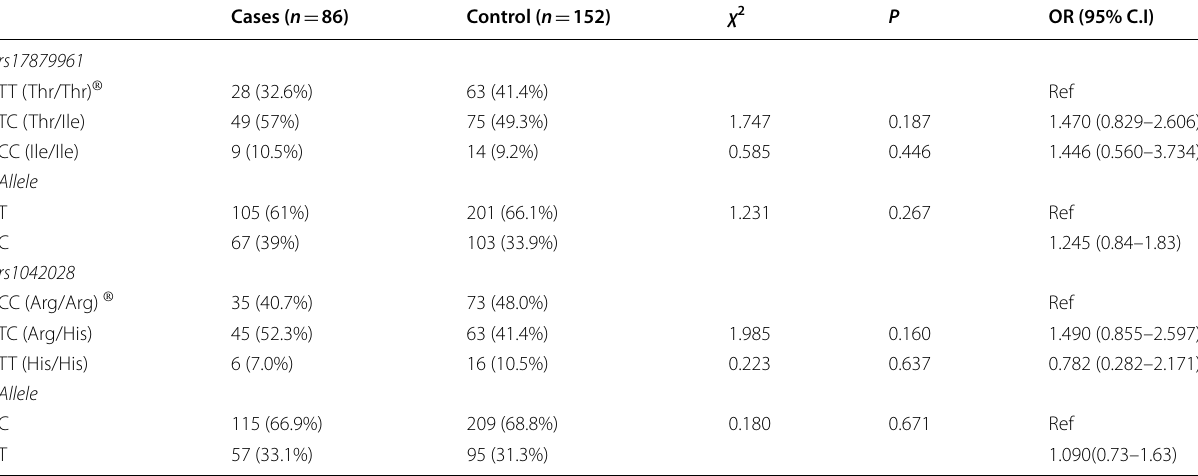
Table 4 The genotype and allele distribution of rs17879961 and rs1042028 polymorphisms among cases and